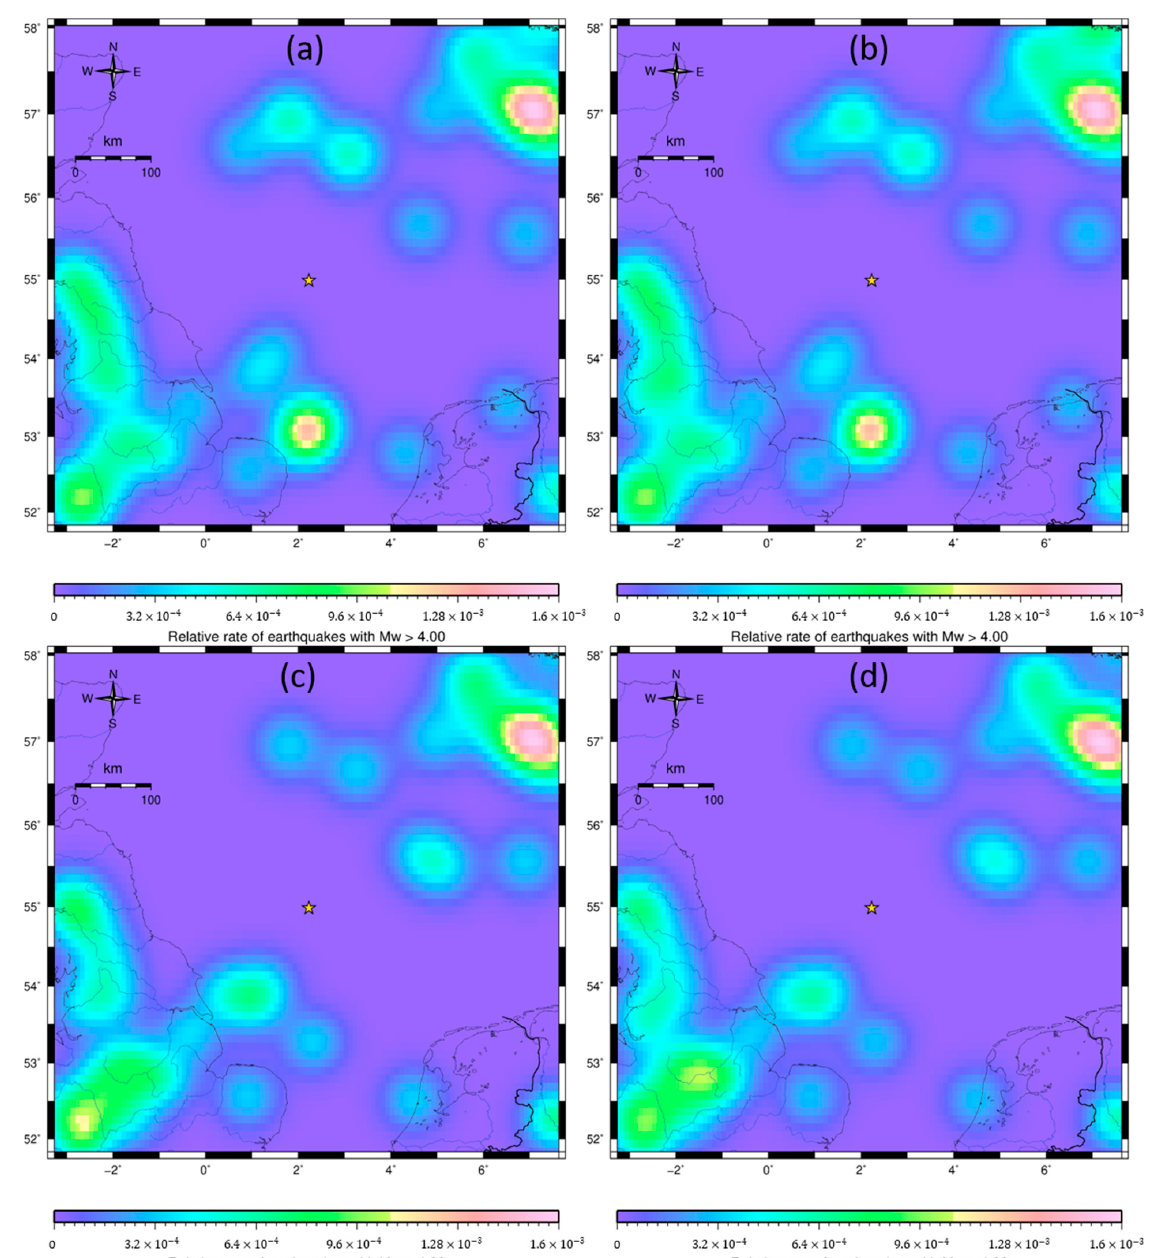
Figure 5. Smoothed gridded seismicity heat map showing the relative activity rate for ( a ) SS-G09-GR, ( b ) SS-G09-RE, ( c ) SS-NRC12-GR, and ( d ) SS-NRC12-RE. Yellow star indicates the center of the wind farm zone.